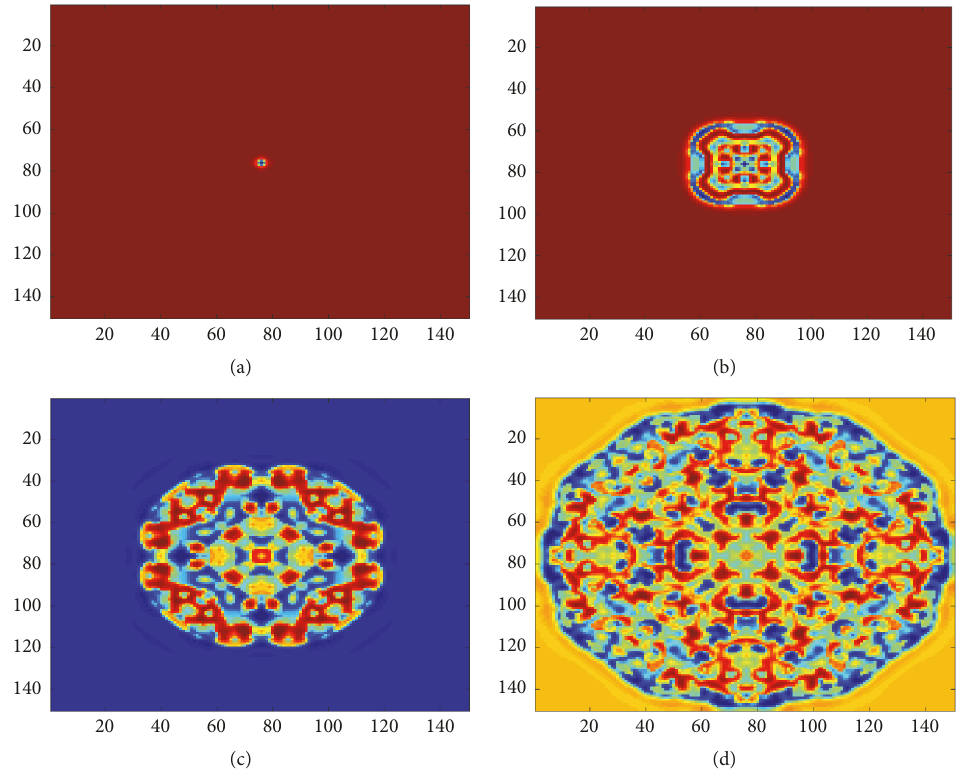
Figure 5: The snapshots of spatial distribution of membrane potential with color scale for neurons in the square array network for 𝑘 = 0.7 and 𝐷 = 1 at (a) 𝑡 = 2 time units, (b) 𝑡 = 75 time units, (c) 𝑡 = 170 time units, and (d) 𝑡 = 300 time